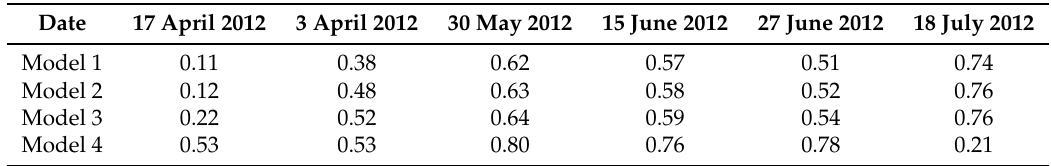
Table 4. r 2 values of four linear regression models with fluorescence and spectrometer indices, grouped by the different measurement dates in the year 2012 on field LW. All linear models are significant with p -values <